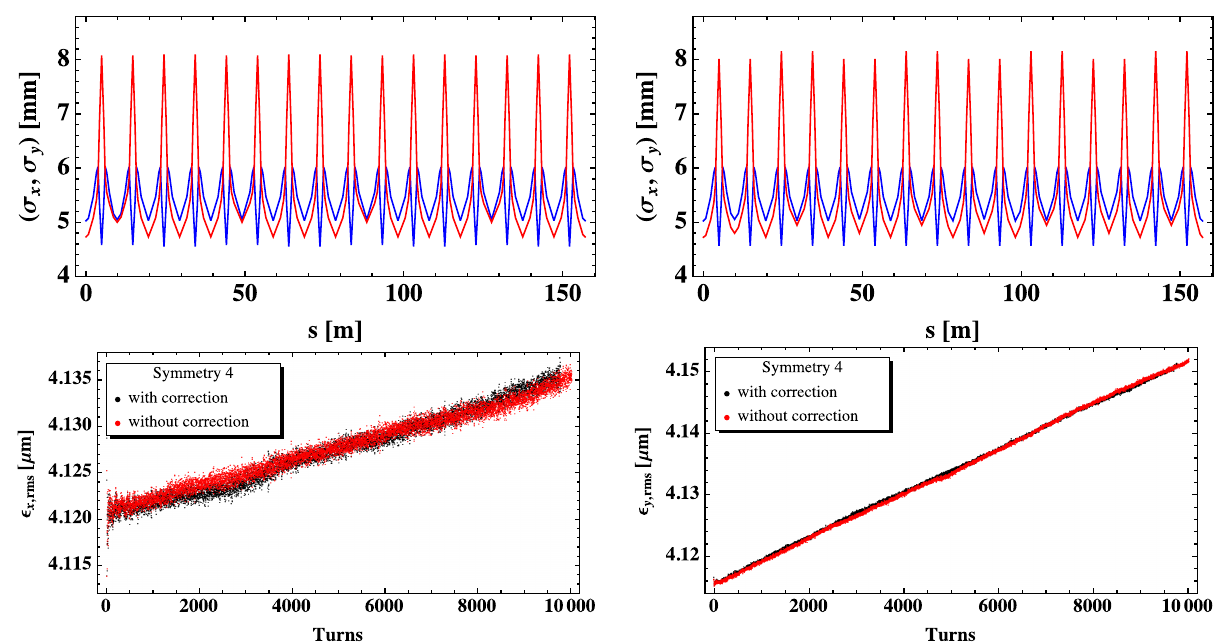
FIG. 17. One rms beam envelope (top) and time evolution of the emittance (bottom) of the regular 16-cell triplet lattice with fourfold symmetry and a working point of Q x =Q y ¼ 4 . 28 = 3 . 55 . The beam envelope has been calculated using the design transverse normalized rms emittance of 2 . 5 μ m and the rms momentum spread corresponding to the design longitudinal emittance of 2.8 eVs. The one rms beam envelope with beta-beating correction is shown on the upper left and without beta-beating correction on the upper right. The horizontal (left) and vertical (right) time evolution of the emittance for the lattice with and without beta-beating correction is shown on the